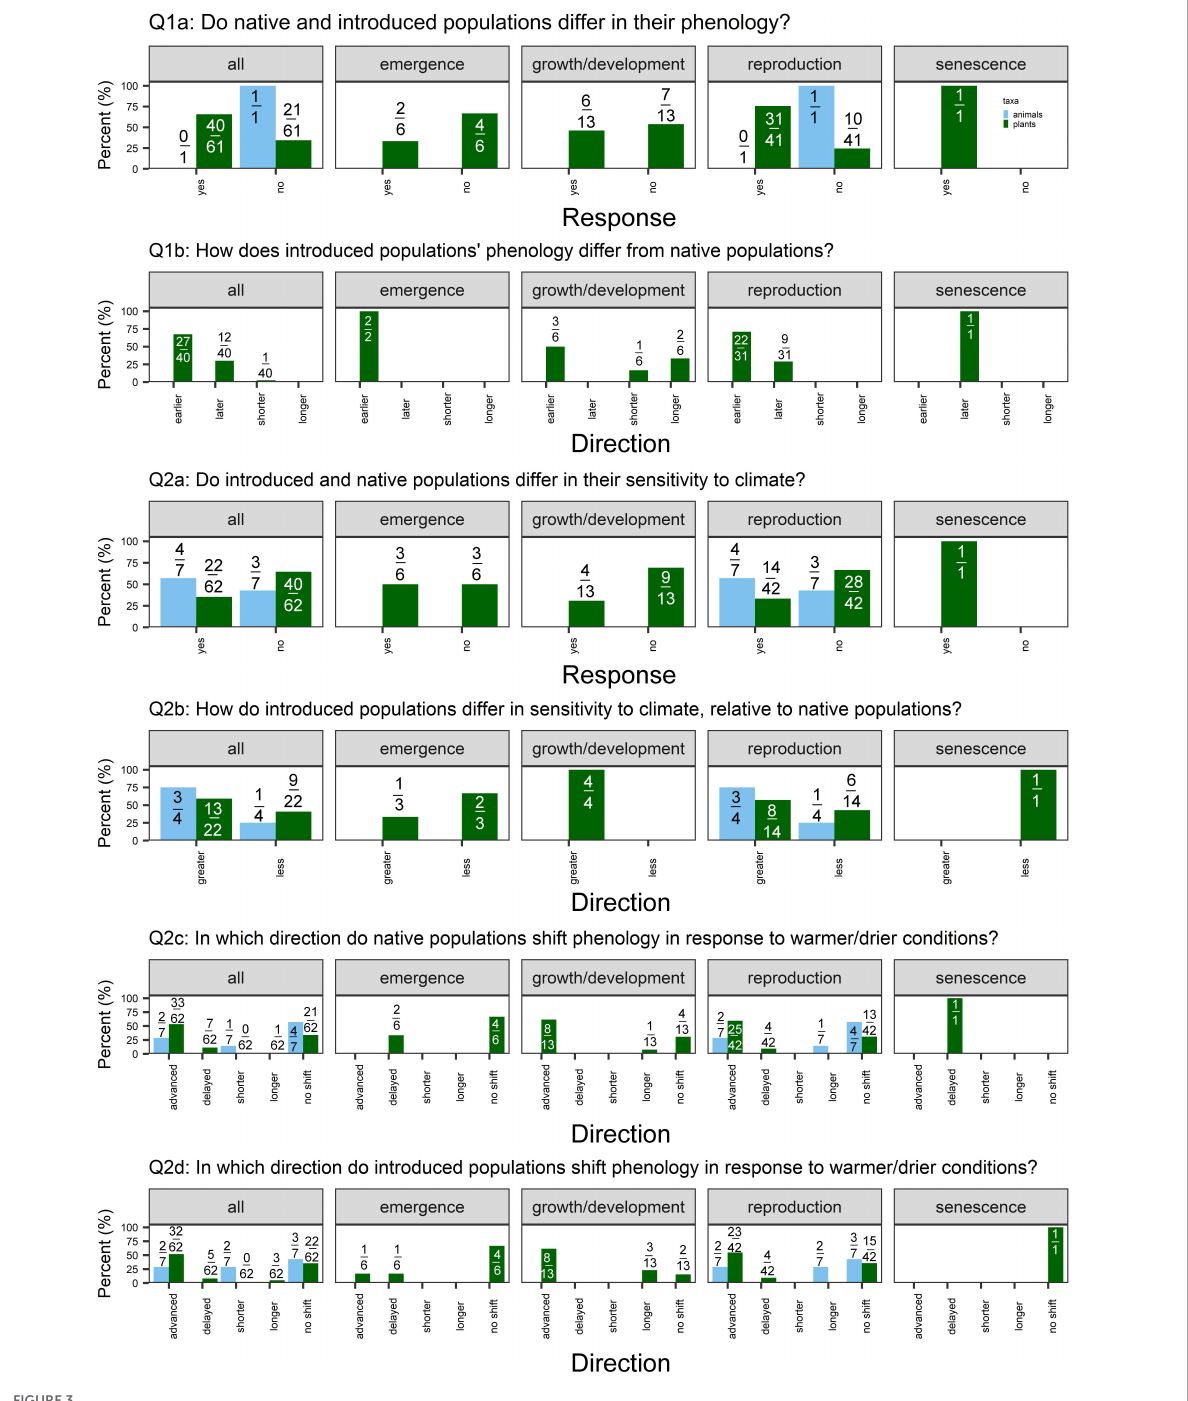
FIGURE3 Percent of cases supporting or contradicting each of the questions outlined in the Section “Materials and methods” for all phenophases, emergence, growth and development, reproduction, and senescence (left to right), split by taxa [light blue = animals (7 cases total; 6 insects, 1 bird); green = plants ( n = 62 cases)]. Values are the number of different responses for each question out of the total number of cases that addressed that question. (Q1a) We examine whether non-native populations in their native vs. introduced range differ in their mean phenology, where “yes” indicates a significant difference ( α = 0.05). (Q1b) Of the studies that detect a significant difference in mean phenology, we ask whether introduced populations demonstrate earlier or later phenology (for phenology measured as day of year of an event) or shorter or longer phenological duration (for phenology measured as length of event or time between events) relative to native populations.